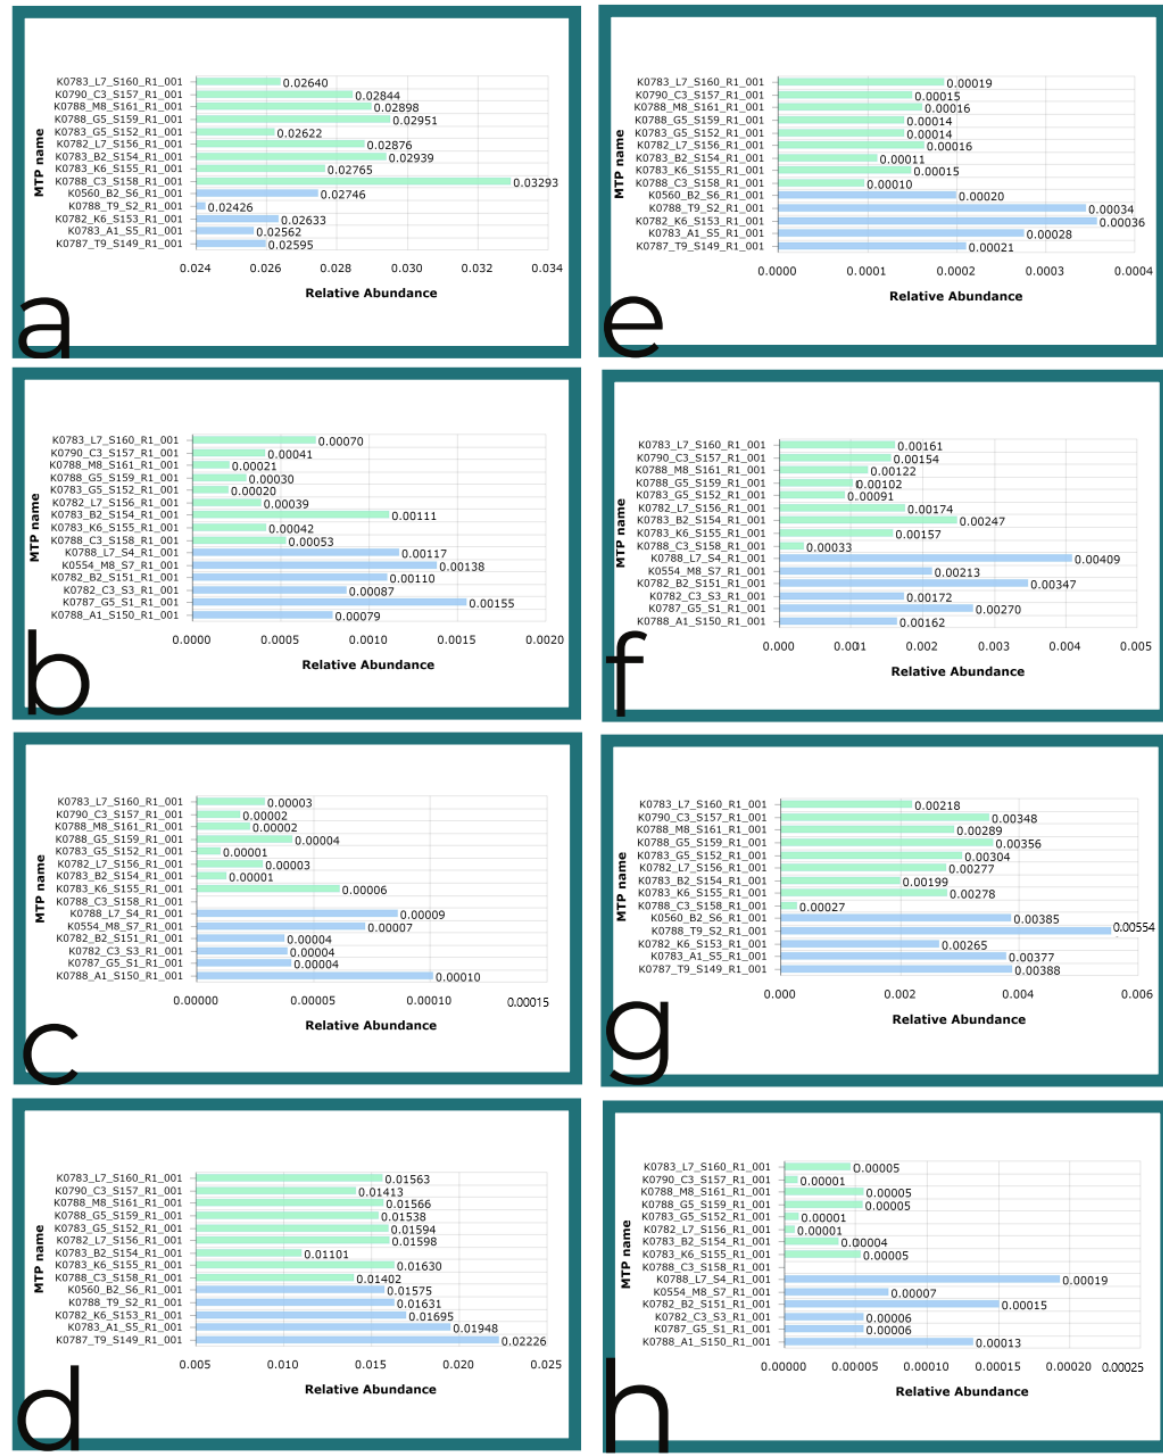
Figure 5. Functional analysis with the Kruskal – Wallis test: ( a ) Assimilatory nitrate reductase for the Green Trail vs. Red Trail; ( b ) Benzene toluene chlorobenzene dioxygenase ferredoxin component for the Green Trail vs. Blue Trail; ( c ) Beta-lactamase for the Green Trail vs. Blue Trail; ( d ) Halo acetate dehalogenase for the Blue Trail vs. Red Trail; ( e ) Propanediol dehydratase for the Green Trail vs. Red Trail; ( f ) Putrescine ornithine dehydratase for the Green Trail vs. Blue Trail; ( g ) Stigmatellin polyketide synthase for the Green Trail vs. Red Trail; ( h ) Lichenysin synthetase for the Green Trail vs. Blue